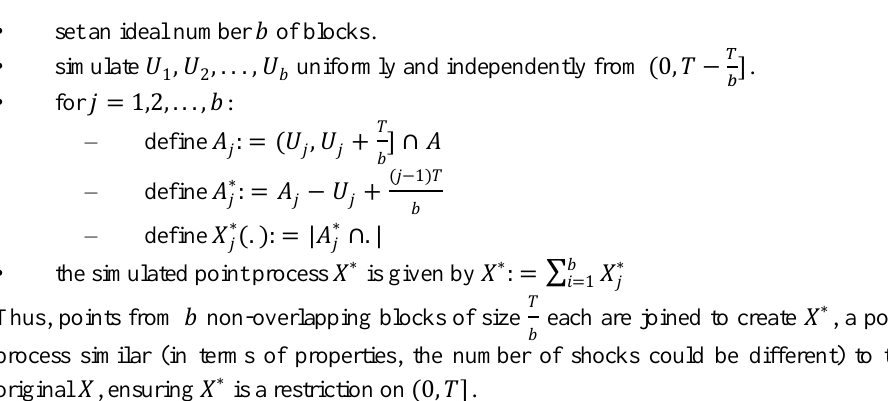
Fig. 8. Bootstrapping NASDAQ-100 and subsequently, detecting change-points, through R . With an observed point pattern A , with terminal time T , the method runs